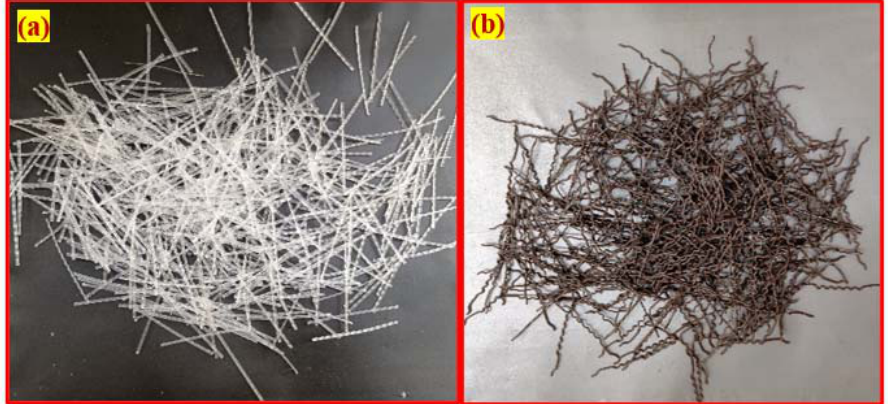
Figure 5. Fibers type used in this research: ( a ) Polypropylene. ( b ) Steel.